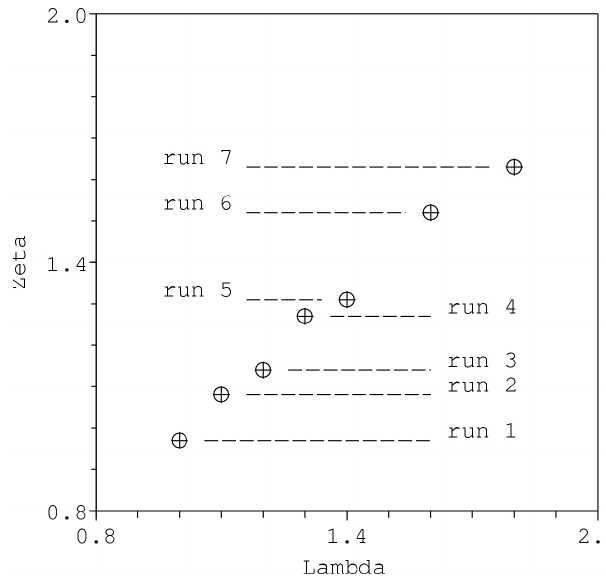
Fig. 9. Computed ζ value as a function of the initial half thickness λ